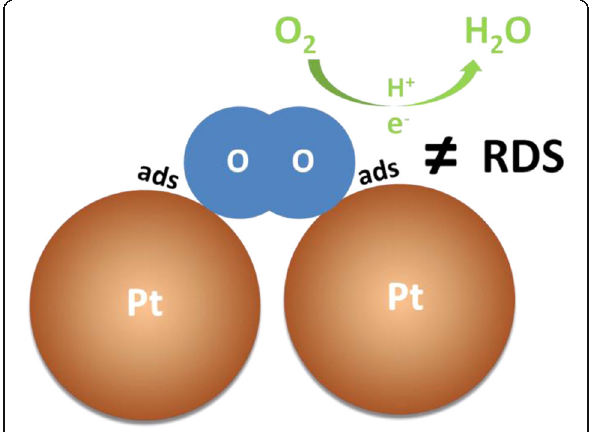
Fig. 4 Illustration of ORR mechanism